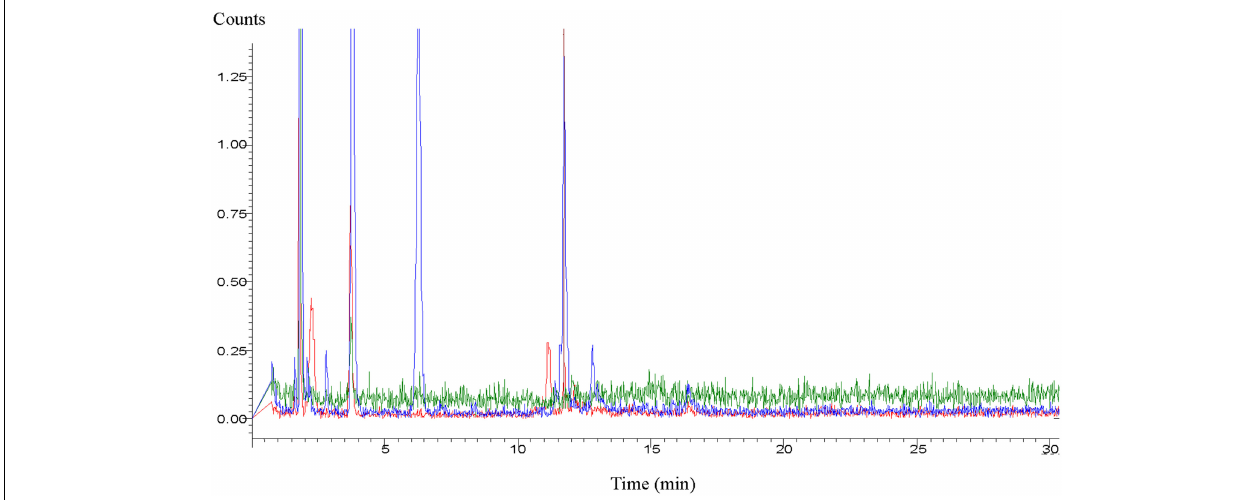
FIGURE 1 | Aged profile of dingo ( Canis lupus dingo ) urine. Blue loop refers to fresh male urine, red loop refers to fresh female urine, and green loop refers to male and female urine aged > 3 months (Graph supplied by M.H.